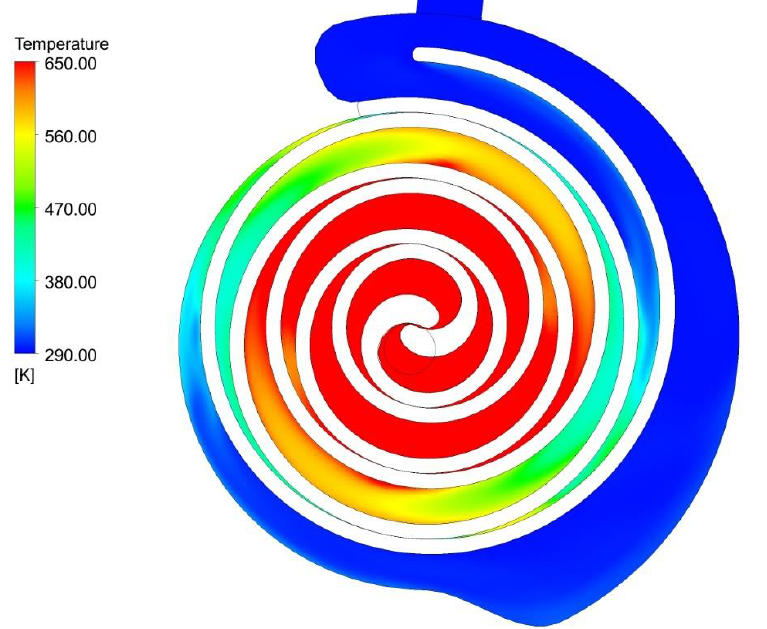
Figure 21. Contour plot of the temperature in a section plan normal to the scroll axis at mid-span. ( t 3 =0.079).